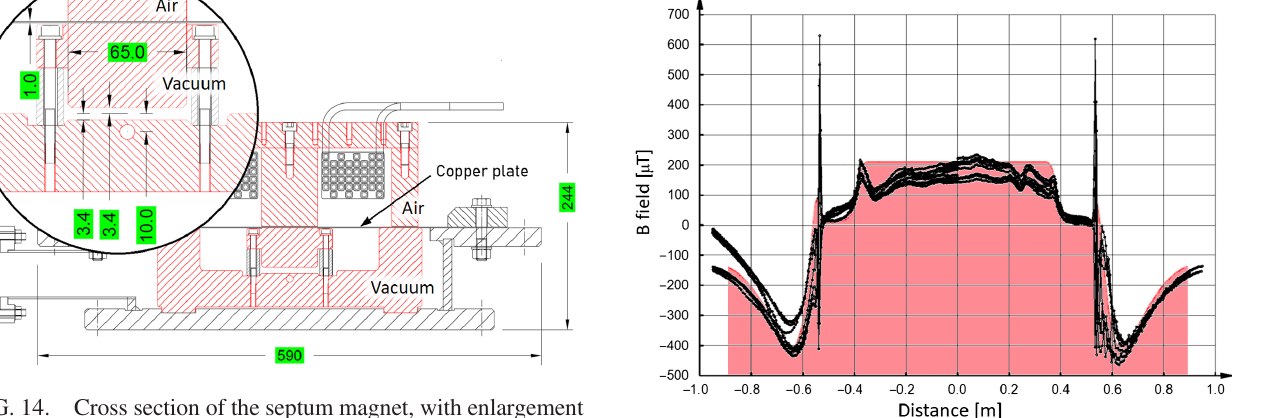
FIG. 16. Simulation (colored area) and measurement (lines) of the septum leakage field. The measurement curves show several runs overlaid, with differences mainly due to hysteresis from varying magnet